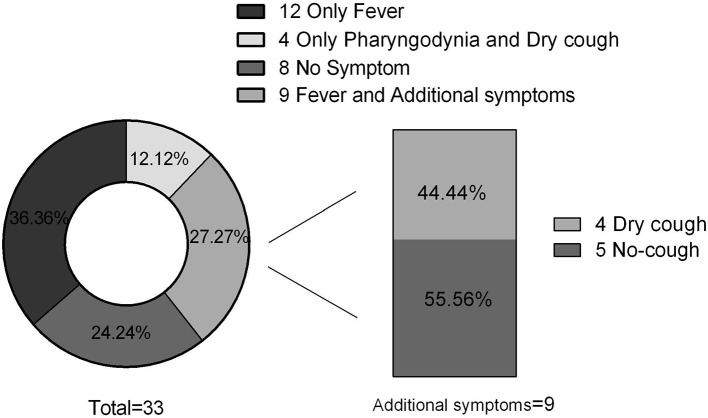
Signs and symptoms.